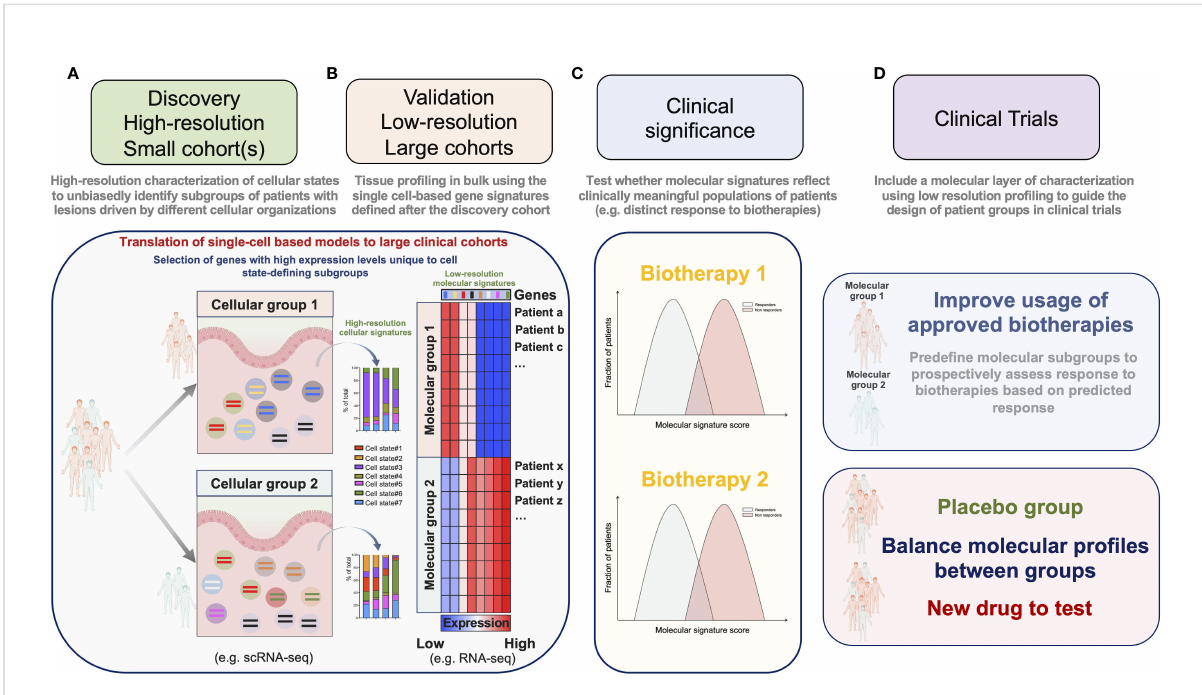
FIGURE 2 A 2-steps strategy for the implementation of molecular strati fi cation criteria into the design of clinical trials. (A) In a “ molecular discovery ” phase, relevant cellular signatures are fi rst identi fi ed by applying high-resolution single-cell pro fi ling to a small cohort of patients. (B) In a “ clinical association ” phase high-resolution-based signatures are con fi rmed on a large number of patients by projecting the data obtained after low- resolution pro fi ling onto a model devised during the “ molecular discovery ” phase. (C) Molecular scores derived from the agnostically identi fi ed signatures are then tested for their association with relevant clinical parameters. (D) Molecular criteria are implemented to guide the design of clinical